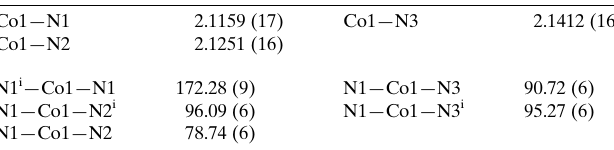
Table 1 Selected geometric parameters (A˚ , (cid:5) ).